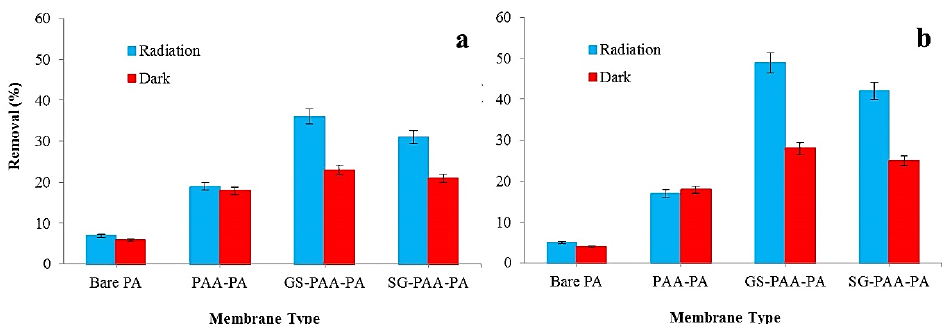
Figure 12. Comparing the removal performance of standard non-modified membranes with plasmonic-modified membranes. ( a ) performance of different membranes in case of removal of OFX; and ( b ) performance of different membranes in case of removal of MB. Reprinted with permission from [45]. Copyright © 2020, Elsevier.